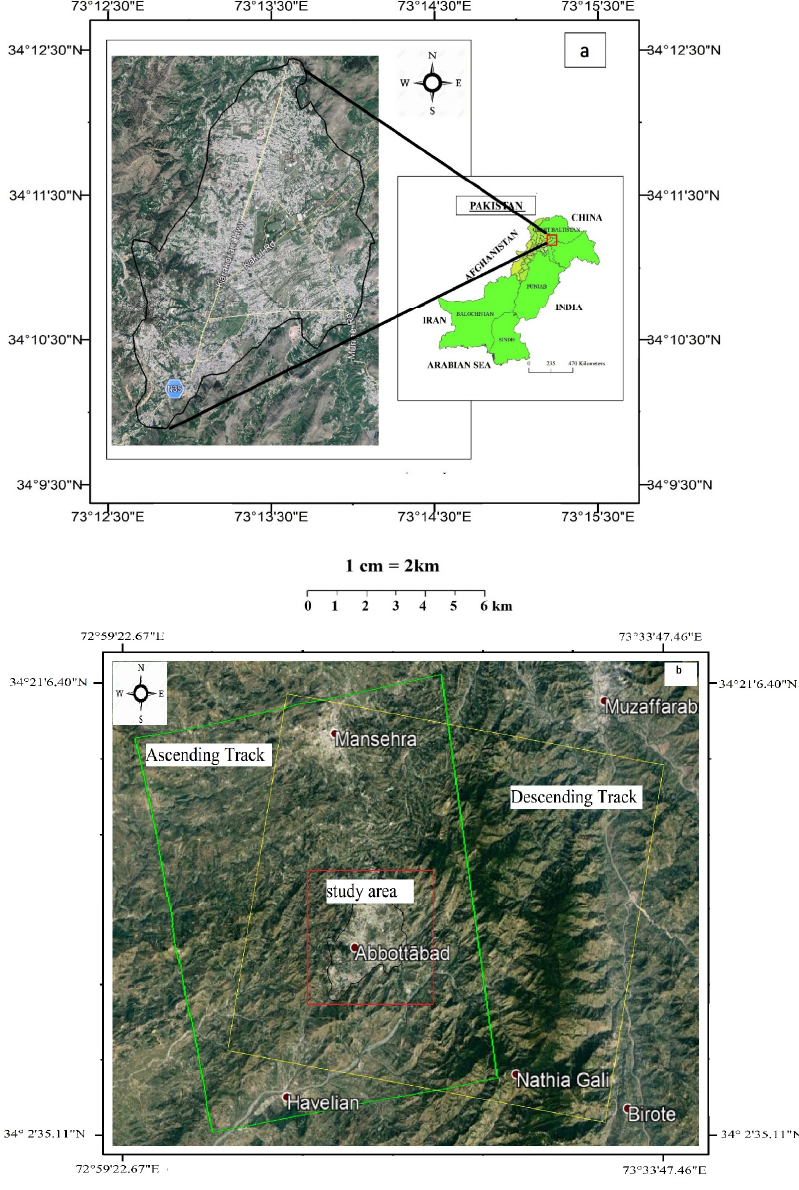
Figure 1. The geographical location of the study area ( a ), and area of interest with a footprint of the master area (both ascending and descending tracks) ( b ). master area (both ascending and descending tracks) ( b